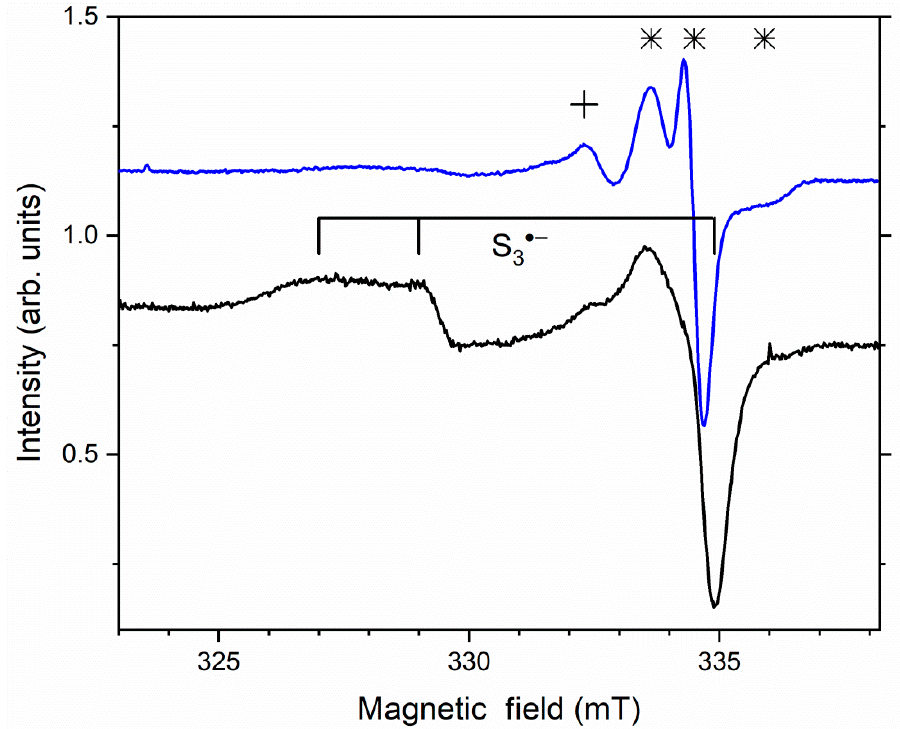
Figure 5. ESR spectra of kyanoxalite (Sample 6) before irradiation (upper curve) and after irradiation with light at a wavelength of 240 nm (lower curve). The signals from the centers of the first, the second and the third type are shown with vertical lines, asterisks and crosses, respectively.